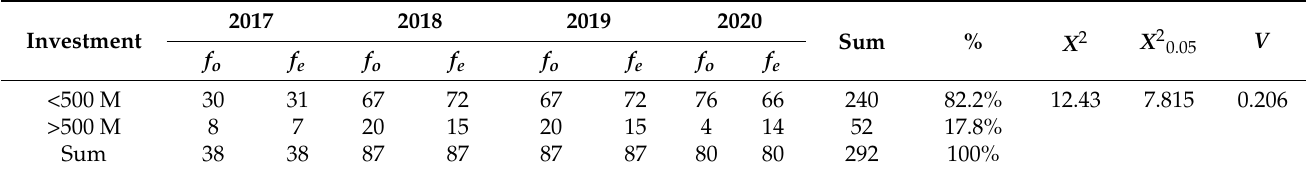
Table 4. Amount of investment dedicated to electromobility strategic issues between the years